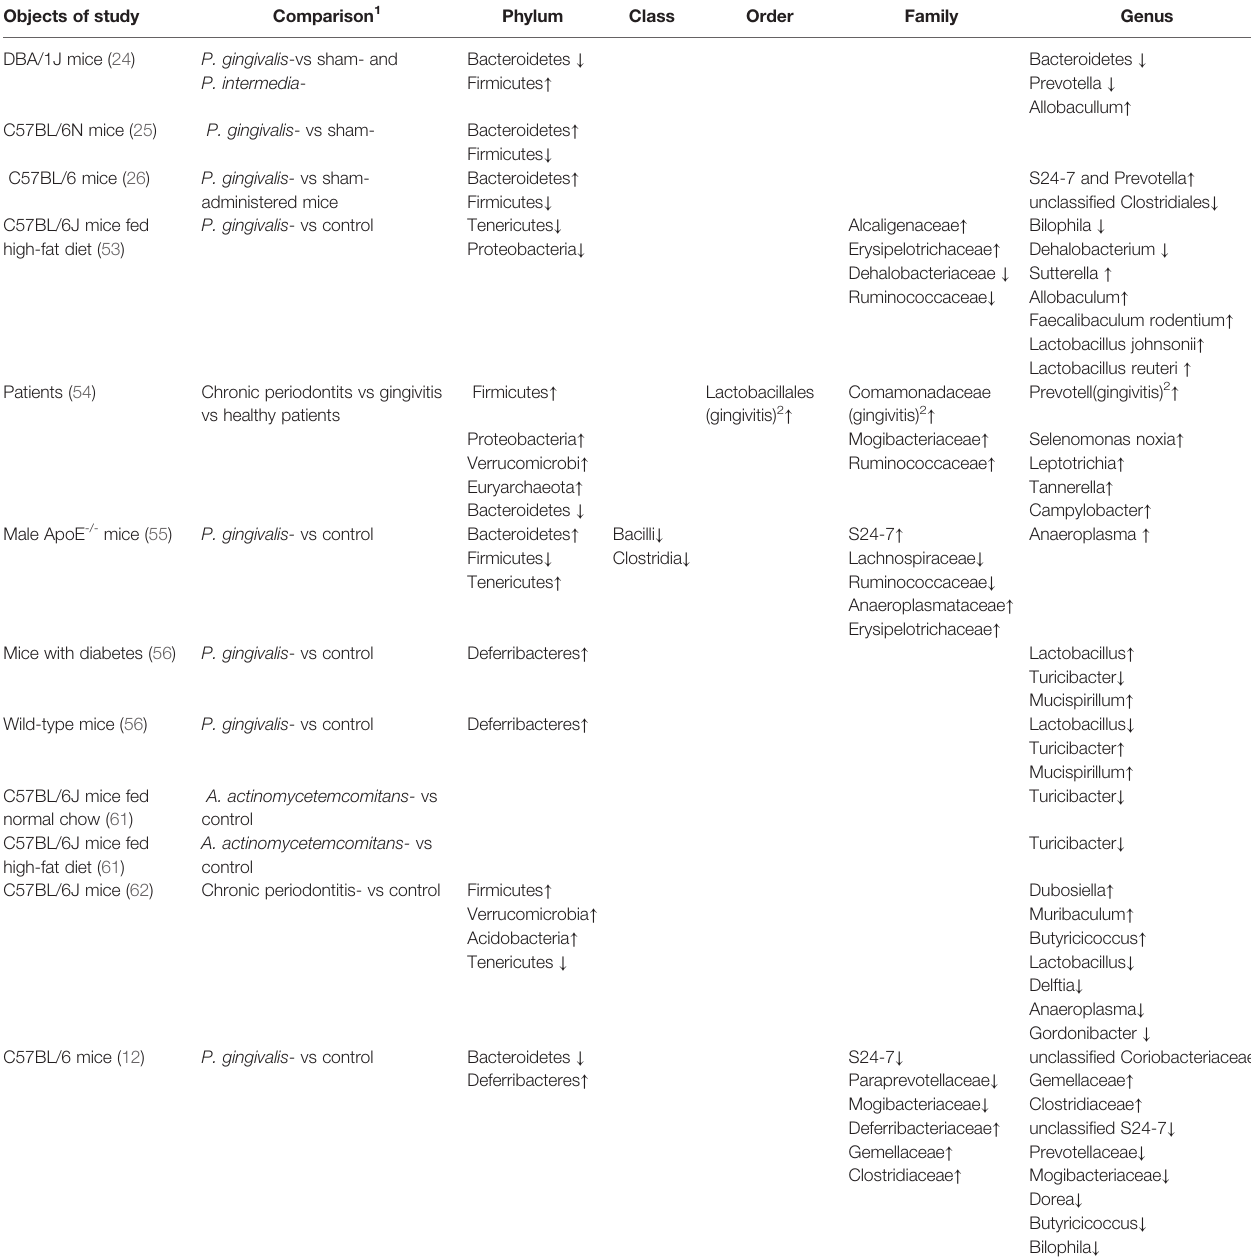
TABLE 1 | Main studies about the effects of periodontal pathogens on the intestinal microbiota. Objects of